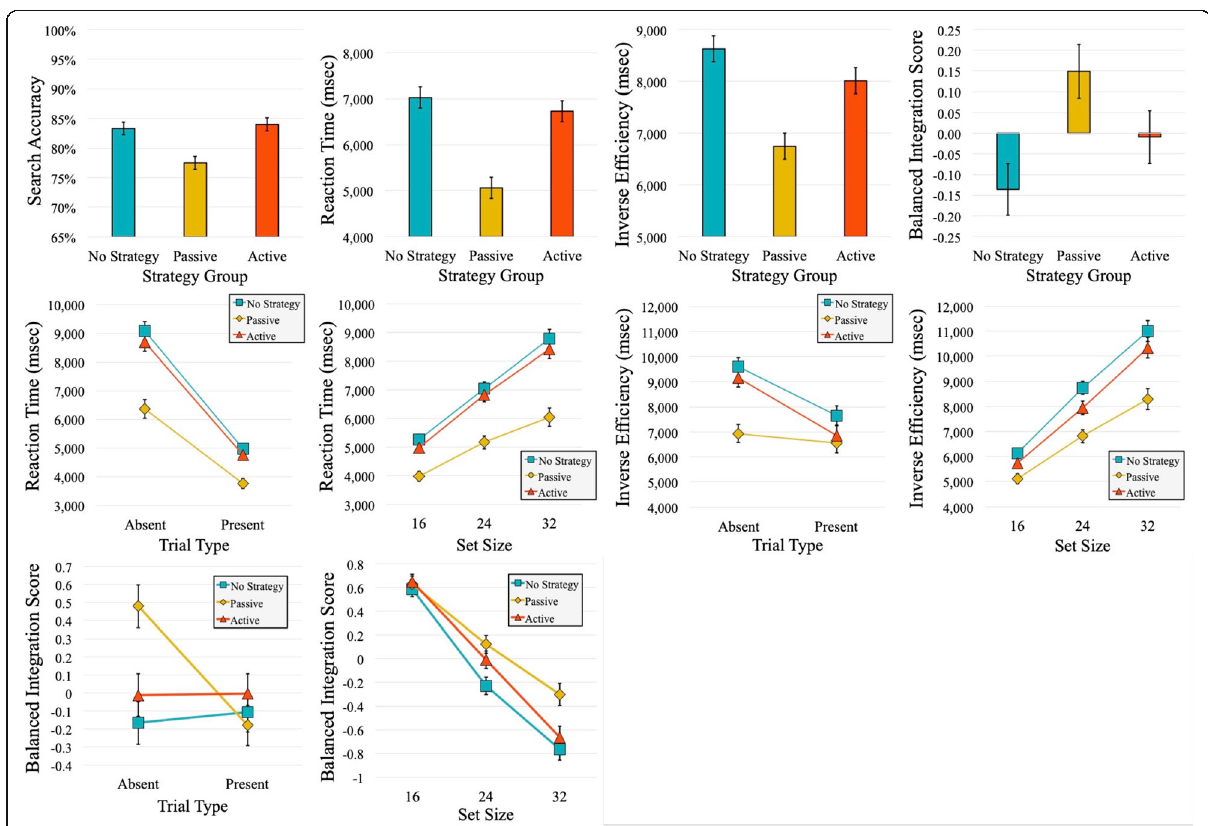
Fig. 3 Significant main effects and interactions with strategy, from experiment 1. The top row presents all main effects, and the bottom row presents all two-way interactions. Error bars represent one standard error of the mean